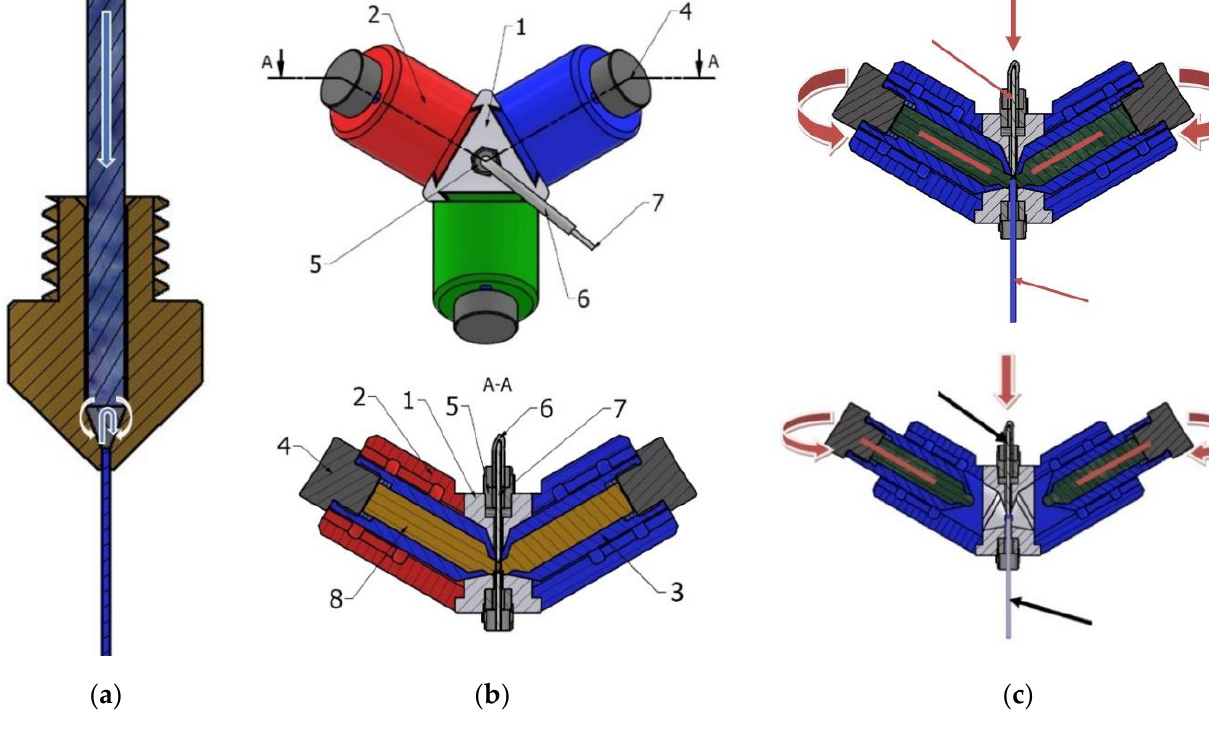
Figure 5. Fabrication setup.